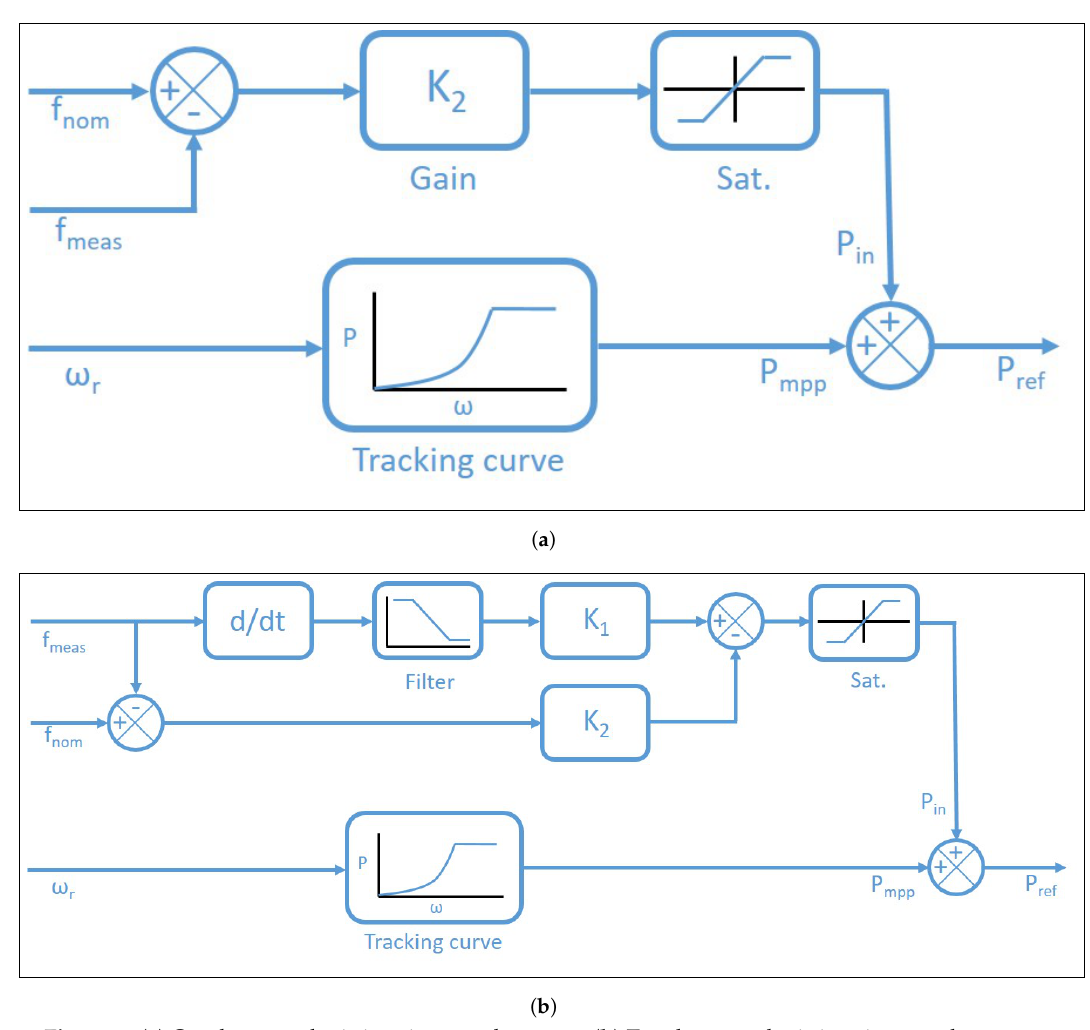
Figure 1. ( a ) One-loop synthetic inertia control strategy, ( b ) Two-loop synthetic inertia control strategy.